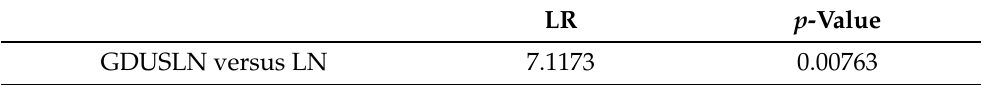
Table 15. Likelihood ratio statistics and their p -values on bladder cancer